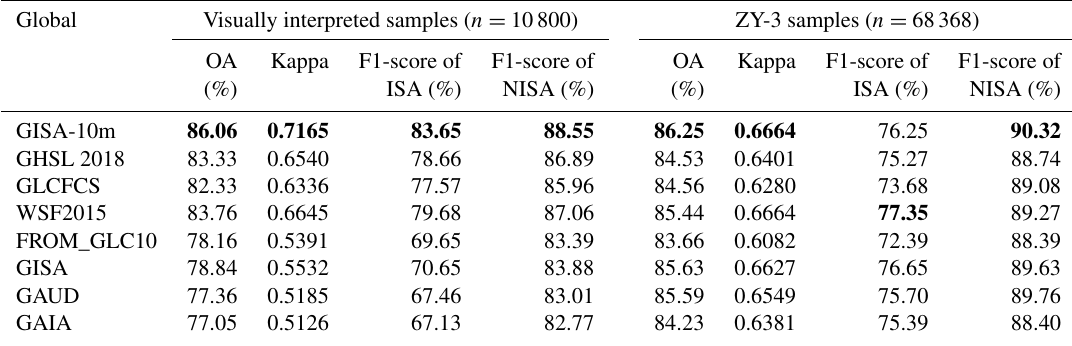
Table 3. Results of quantitative accuracy assessment via visually interpreted and ZY-3 samples between GISA-10m and the existing ISA datasets. OA represents the overall accuracy. Bold numbers represent the highest value for each metric. Global